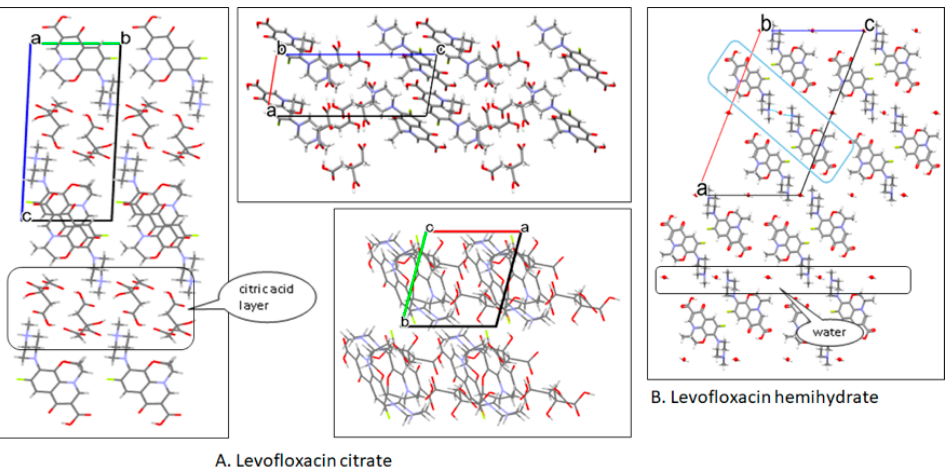
Figure 10. Crystal packing of levofloxacin citrate from a, b, and c view-sites compared to LF-hemihydrate as the parent compound.